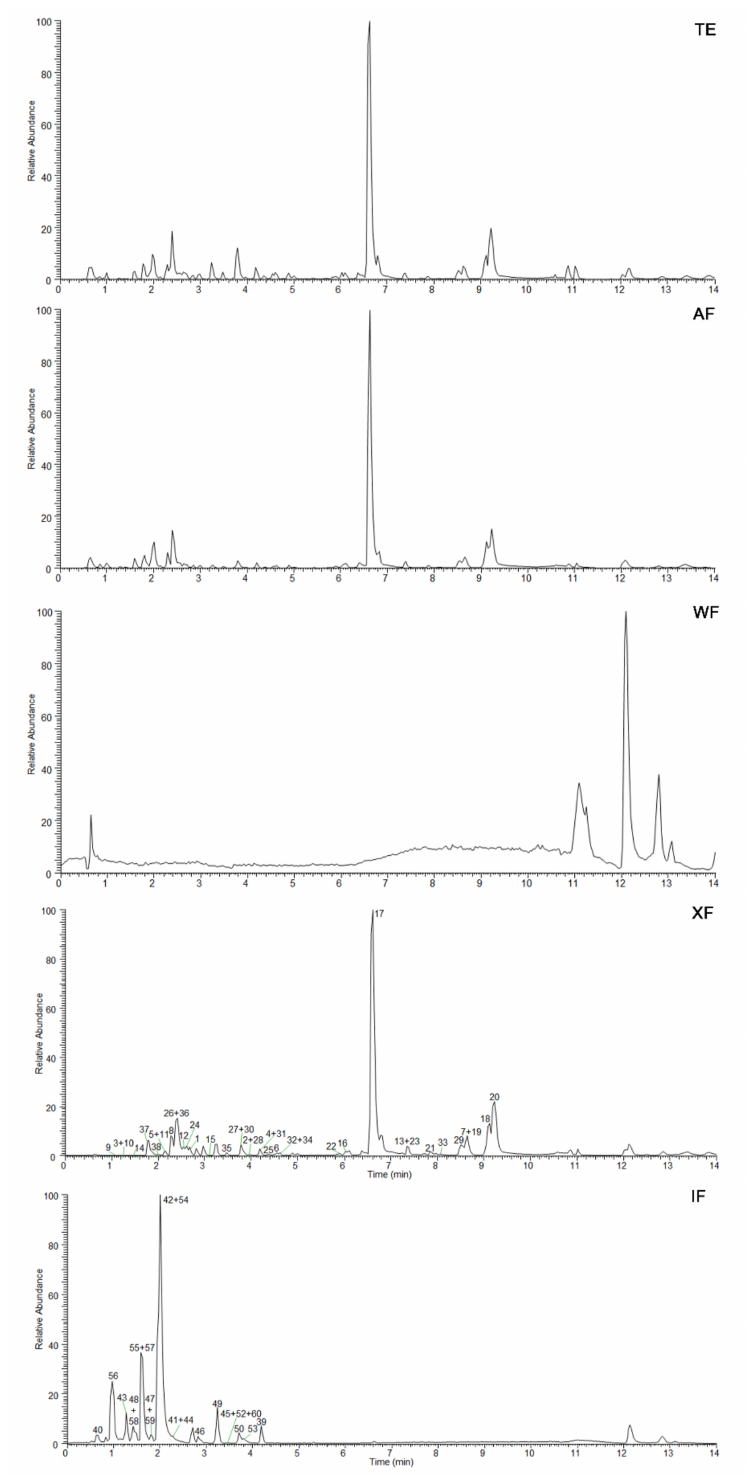
Figure 2. BPC chromatograms of TE, AF, WF, IF and XF, respectively. Chromatographic conditions: Column: ACQUITY UPLC ® BEH C18 (1.8 µ m, 2.1 × 100 mm); mobile phase: FA-H 2 O (1:1000, v / v ) (A) and ACN (B) in the gradient program: 0–6 min, 15–45% B; 6–9 min, 45% B, 9–10 min, 95% B; 10–14 min, 95% B; column temperature: 30 ◦ C; flow rate: 0.4 mL/min; injection volume: 2 µ L. Mass 3.2 kV; capillary temperature: 320 ◦ C; ion source temperature: 300 ◦ C; sheath gas (N 2 ): 40 L/h; auxiliary gas (N 2 ): 10 L/h; normalized collision energy (NCE): 35 V; scan mode: full scan; scan